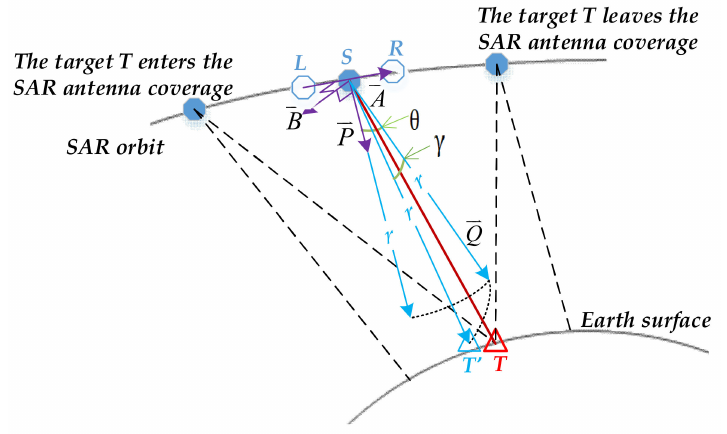
Figure 6. Squint sliding-spot imaging of target by the SAR satellite and the geometric forward process based on antenna pointing vector.